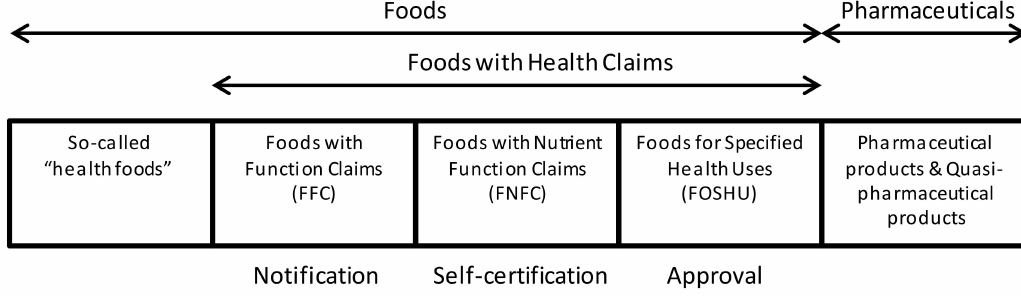
Figure 2. Categories ranging from food to pharmaceuticals containing Foods with Health